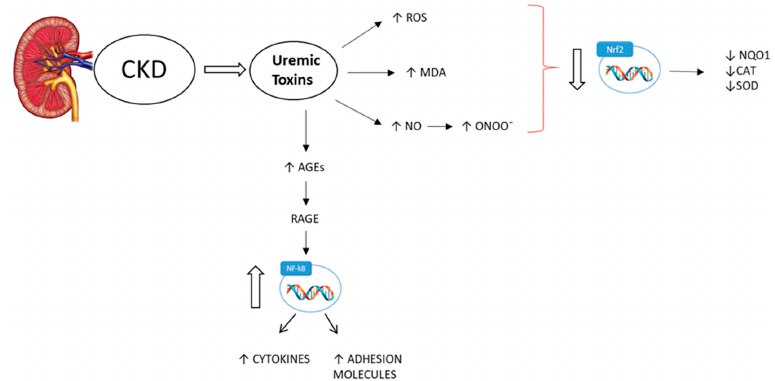
Figure 2. During chronic kidney disease (CKD), there is a considerable increase in oxidative stress due to uremic toxins. There are increases in reactive oxygen species (ROS), nitric oxide (NO) and markers of oxidative stress—such as malondialdehyde (MDA), peroxynitrite (ONOO − ) and advanced glycation end products (AGEs), which interact with AGE receptors and determine the activation of the nuclear factor kappa-light-chain-enhancer of activated B cells (NF- κ B), with a consequent increase in cytokines and adhesion molecules. The oxidative stress condition is reflected in a reduction in the activity of the transcription factor nuclear factor erythroid 2-related factor 2 (Nrf2) and, consequently, of the expression of antioxidant and cytoprotective enzymes such as NAD(P)H dehydrogenase [quinone] 1 (NQO1), catalase (CAT) and superoxide dismutase (SOD).